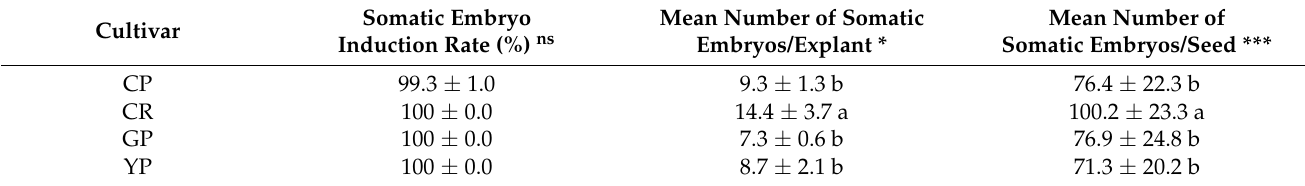
Table 4. Influence of cultivars on somatic embryogenesis of P. ginseng.